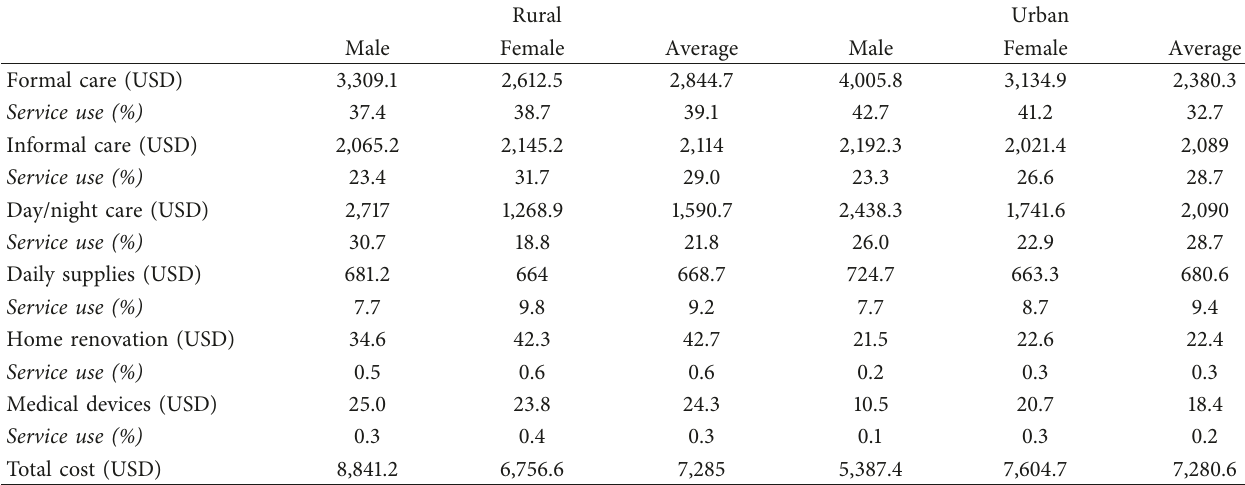
Table 5: Cost on services for rural and urban residents